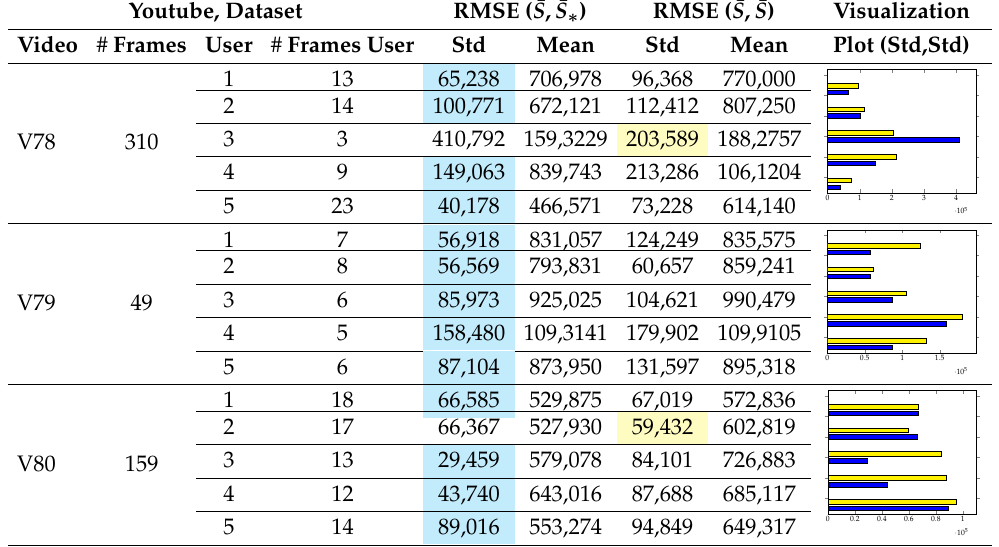
12 of 18 Table 4. Descriptive statistics with RMSE ( ¯ S , ¯ S ∗ ) (target summary against random uniform sample) and RMSE ( ¯ S , ¯ S ) (random uniform sample against random uniform sample). Lower is better. Sam- pling rate: 1 frame per second. Dataset in [7], videos from V71 to V80. Youtube, Dataset